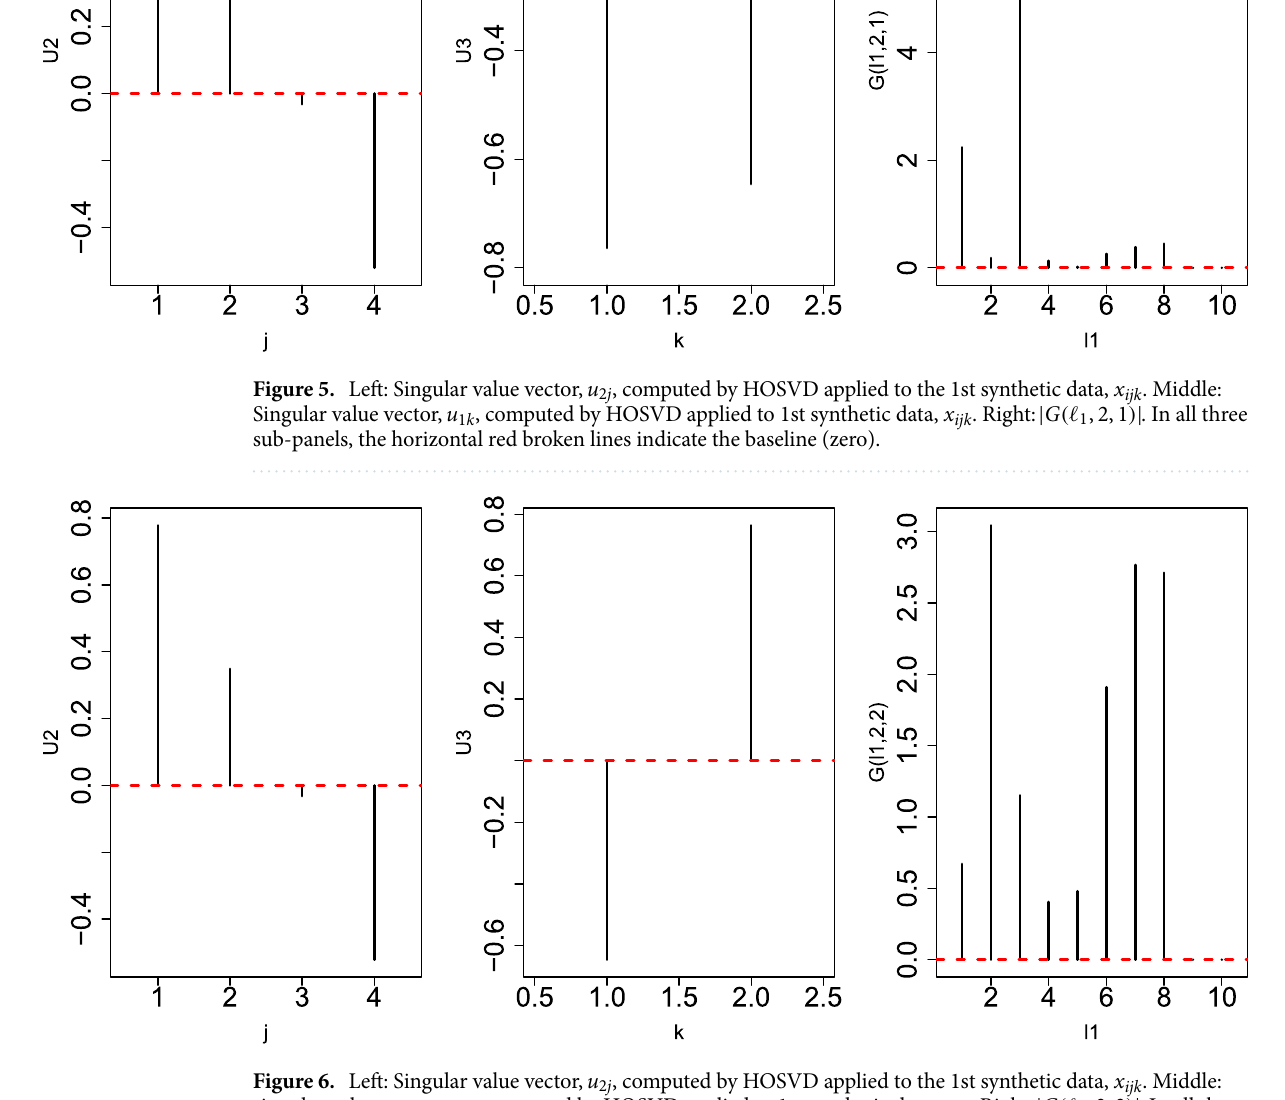
Figure 6. Left: Singular value vector, u 2 j , computed by HOSVD applied to the 1st synthetic data, x ijk . Middle: singular value vector, u 2 k , computed by HOSVD applied to 1st synthetic data, x ijk . Right: | G (ℓ 1 , 2, 2 ) | . In all three sub-panels, the horizontal red broken lines indicate the baseline